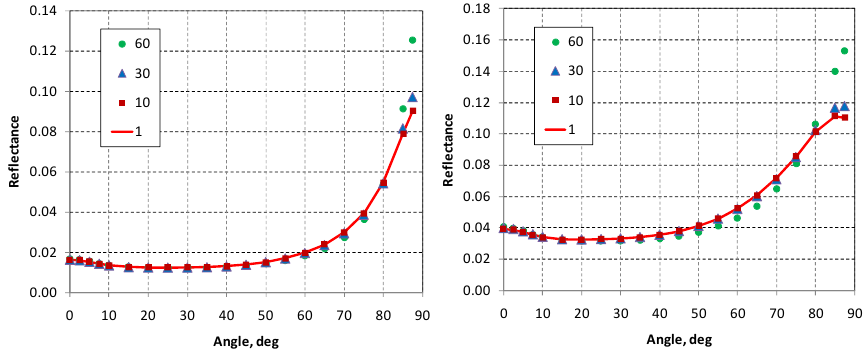
Fig. 2. The reflectance for the aerosol layer computed with RAY at different truncation angles given in the legend. Aerosol model Continental, the normal incidence; τ = 0 . 2 (left) and 0.5